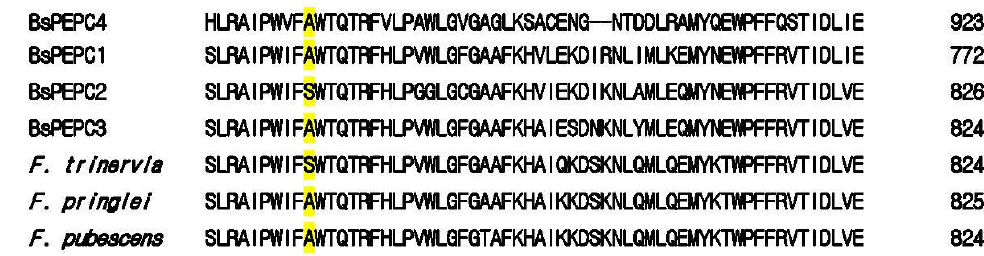
Figure 1. Sequence alignment of Bienertia sinuspersici phosphoenolpyruvate carboxylase (PEPC) isozymes (PEPC1–4) with those from Flaveria species and their characteristic amino acids at position 774 (yellow highlighted). Note that the sequences at this position are identical for the C 4 species F. trinervia and BsPEPC2, with the amino acid serine, while the C 3 species F. pringlei and C 3 –C 4 intermediate species F. pubescens , which have alanine, are aligned with BsPEPC1 and BsPEPC3, which are thought to be C 3 and C 3 –C 4 intermediate PEPCs, respectively. The bacterial-type PEPC counterpart of B. sinuspersici (BsPEPC4) contains serine. The amino acid numbering follows that of PEPC3.